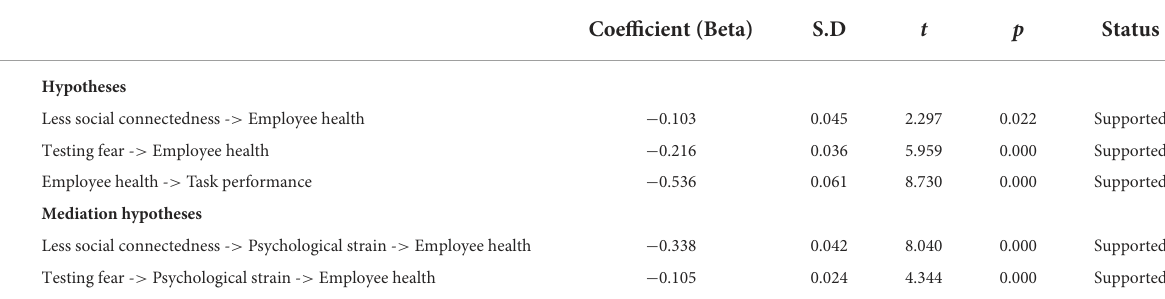
TABLE 5 Hypotheses